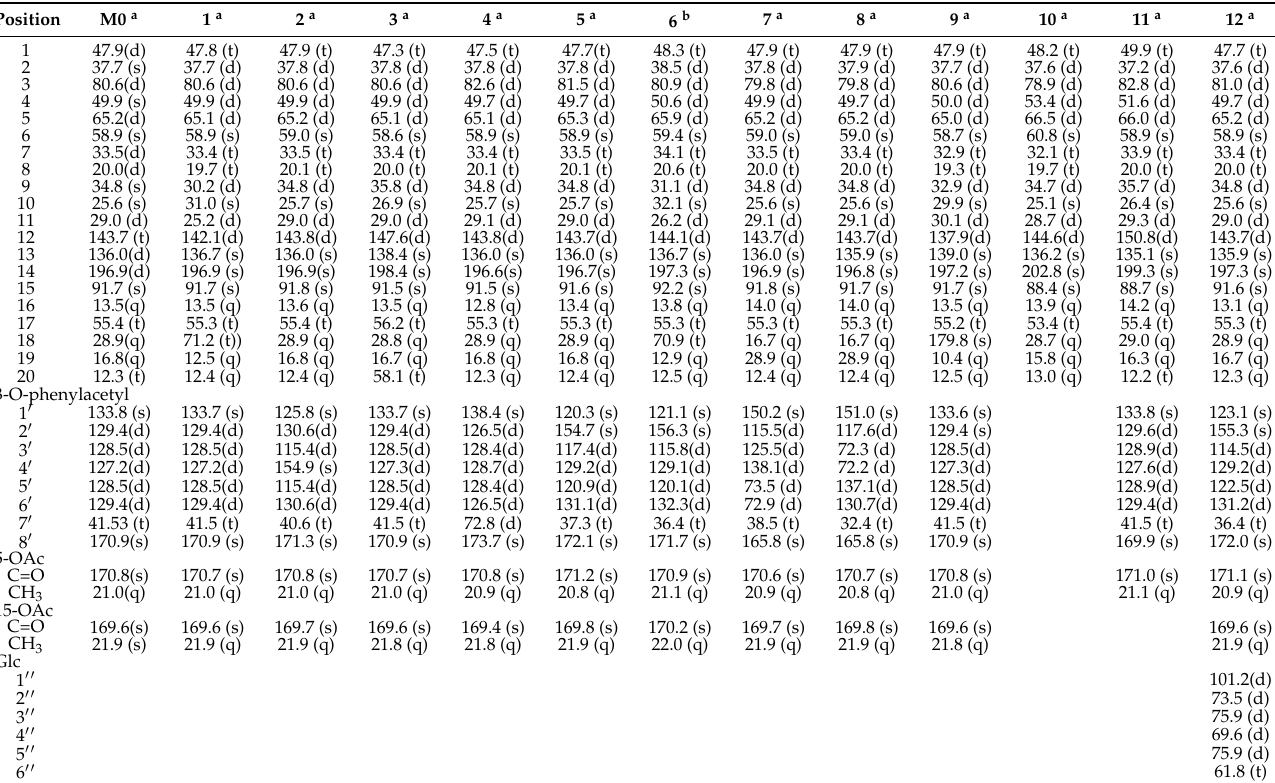
Table 3. The 13 C NMR data for euphorbiasteroid and its transformation products ( 1 – 12